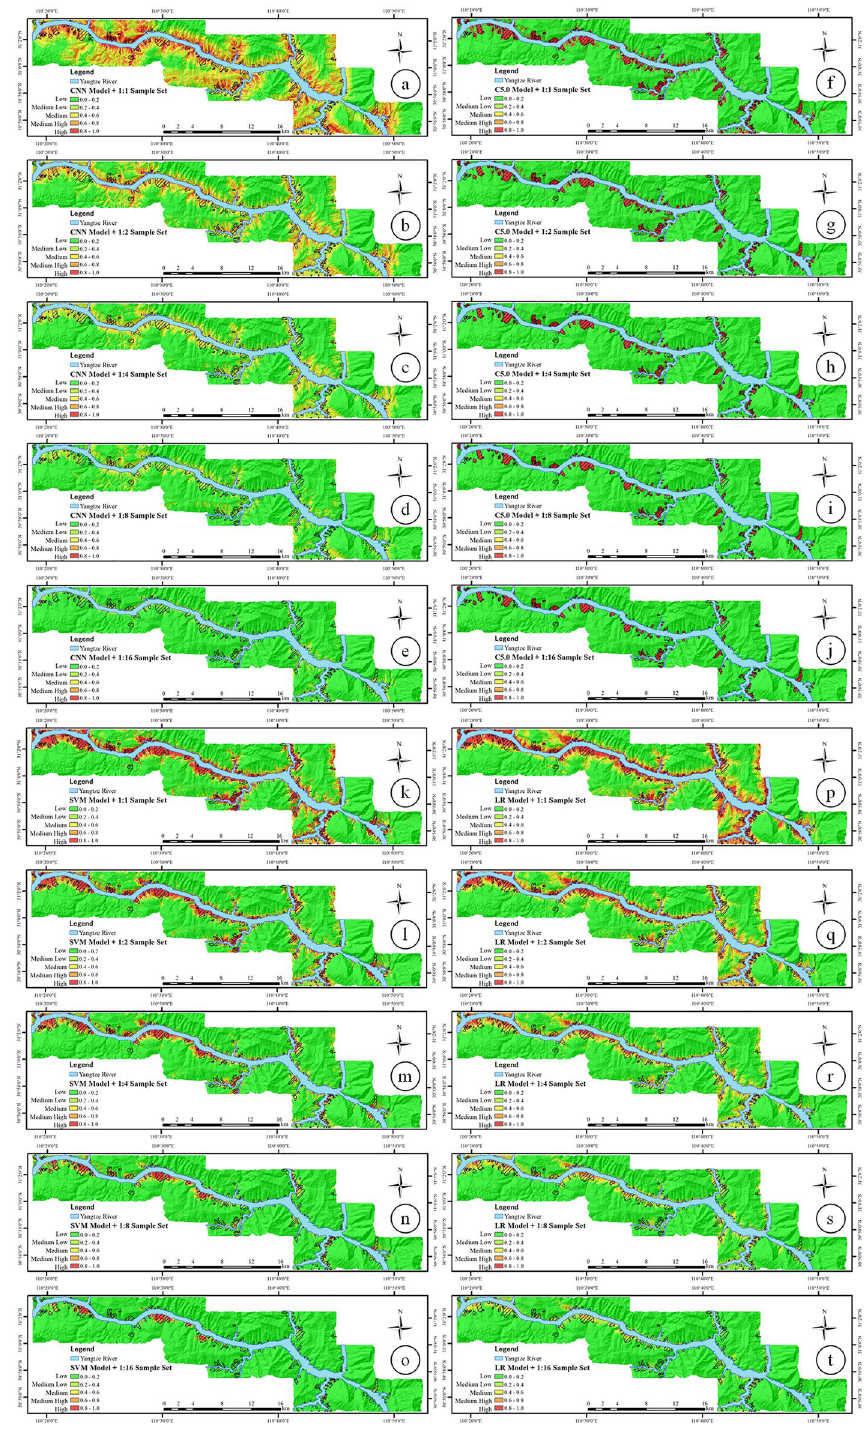
Figure 12. LSZs based on ( a ) 1:1 sample set by CNN model, ( b ) 1:2 sample set by CNN model, ( c ) 1:4 sample set by CNN model, ( d ) 1:8 sample set by CNN model, ( e ) 1:16 sample set by CNN model, ( f ) 1:1 sample set by C5.0 model, ( g )1:2 sample set by C5.0 model, ( h ) 1:4 sample set by C5.0 model, ( i ) 1:8 sample set by C5.0 model, ( j ) 1:16 sample set by C5.0 model, ( k ) 1:1 sample set by SVM model, ( l ) 1:2 sample set by SVM model, ( m ) 1:4 sample set by SVM model, ( n ) 1:8 sample set by SVM model, ( o ) 1:16 sample set by SVM model, ( p ) 1:1 sample set by LR model, ( q ) 1:2 sample set by LR model, ( r ) 1:4 sample set by LR model, ( s ) 1:8 sample set by LR